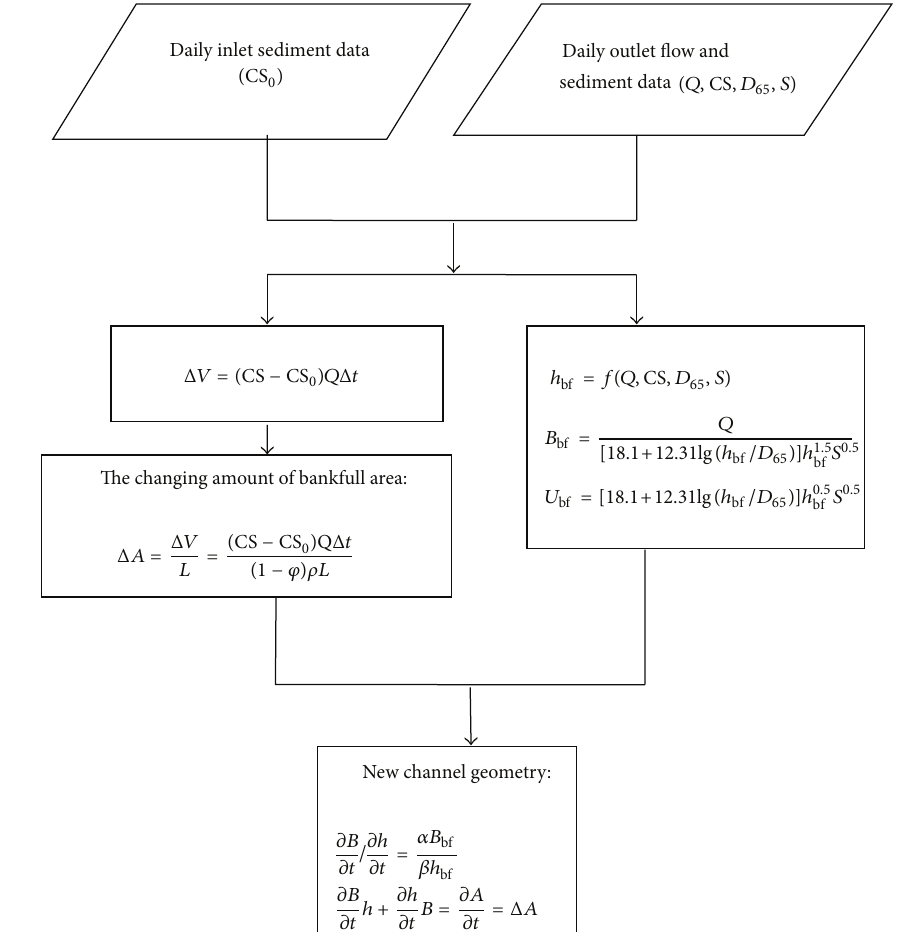
Figure 9: Computational process of the bankfull area computational